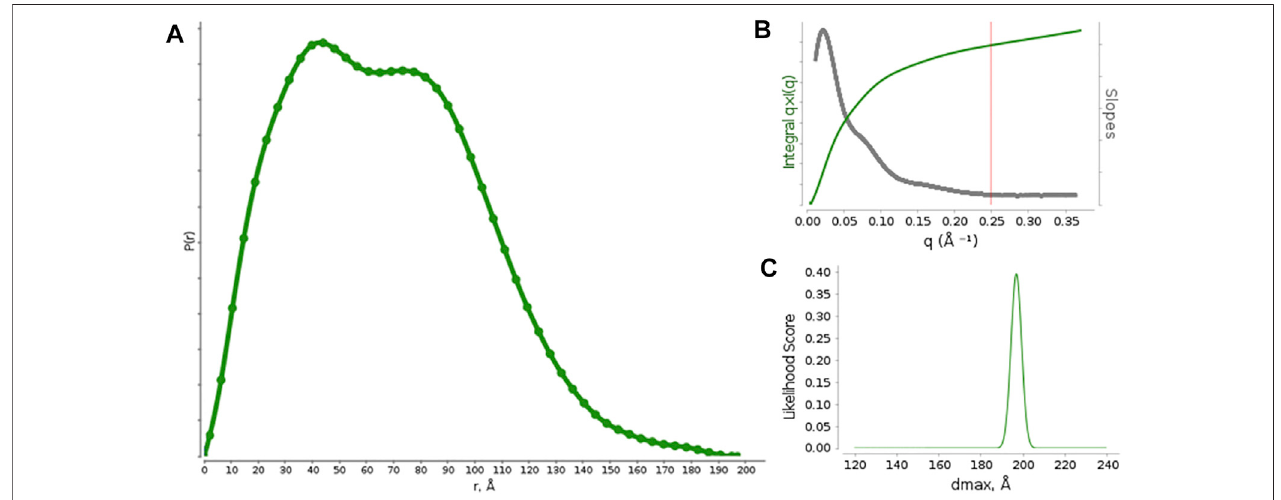
FIGURE1|(A) PairdistributionfunctioncalculatedfromthemeasuredSAXSpro fi lesforrituximab. (B) graphwithsuggested q max (redverticalline)basedonthe q* I (q) vs q curve and its derivative. (C) Likelihood score of D max values calculated for different alpha values by using the Moore function to model P(r)